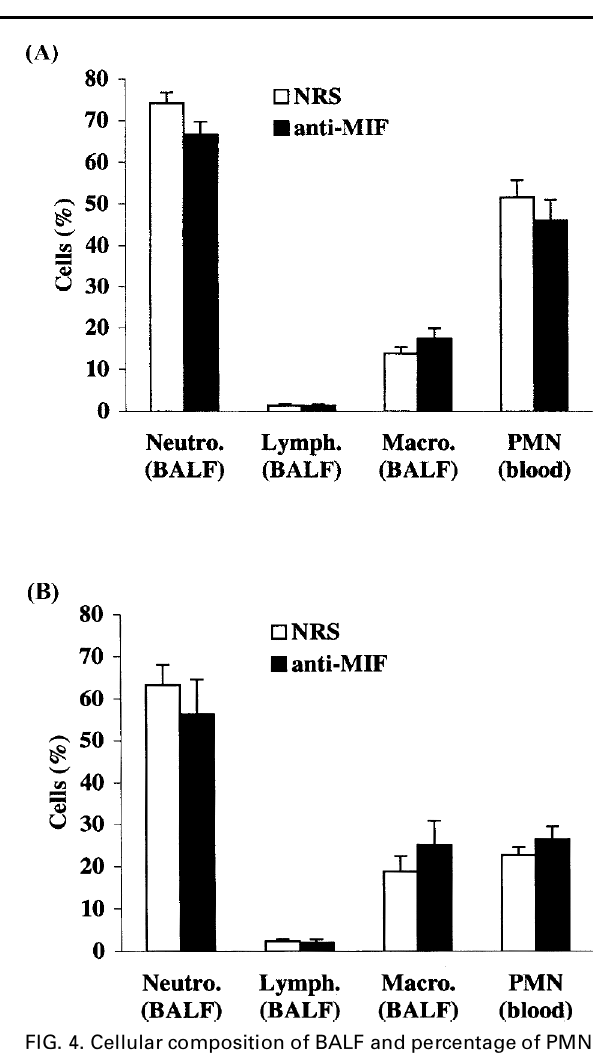
FIG. 4. Cellular composition of BALF and percentage of PMN in blood of anti-MIF-treated and NRS-treated mice 4h (a) and 24h (b) after LPS challenge. Data are presented as mean ± SEM. NRS = NRS-treated mice ( n =8), anti-MIF = anti-MIF- treated mice ( n =8). Eos. = eosinophils, Neutro. = neutrophils, Lymph. = lymphocytes, Macro. = macrophages. At both 4h (a) and 24h (b) after LPS challenge, a similar cellular composition of BALF was demonstrated in anti-MIF-treated and NRS-treated mice. Consistent with the findings in BALF, the number of PMN in blood did not differ significantly between anti-MIF-treated and NRS-treated animals 4h (a) and 24h (b) after LPS challenge. (Epithelial cells and eosinophils in BALF are not included in the